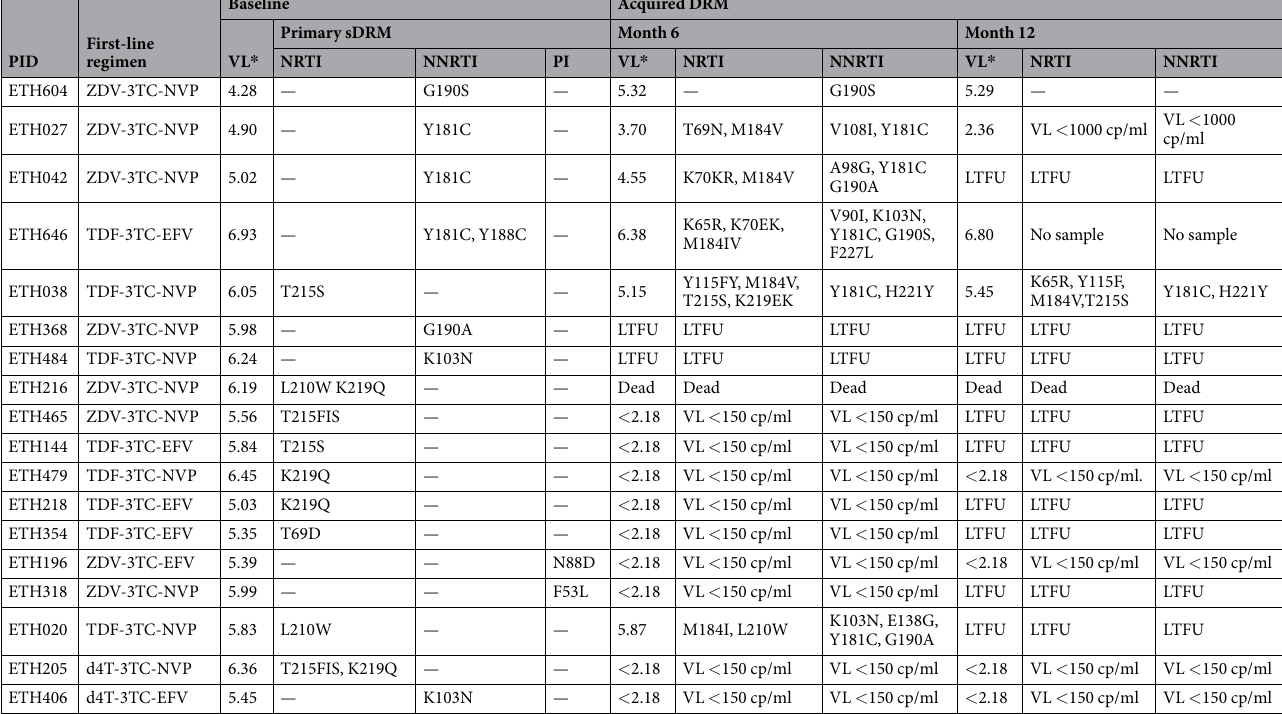
Table 2. Drug resistance mutations detected by population based Sanger sequencing in 18 HIV-1 infected patients at baseline, months six and/or 12. * VL: log 10 copies (cp)/ml. Columns express drug resistance mutations DRM or no DRM detected ( − ) or reasons to no data. LTFU: lost-to-follow-up. TDF: tenofovir;